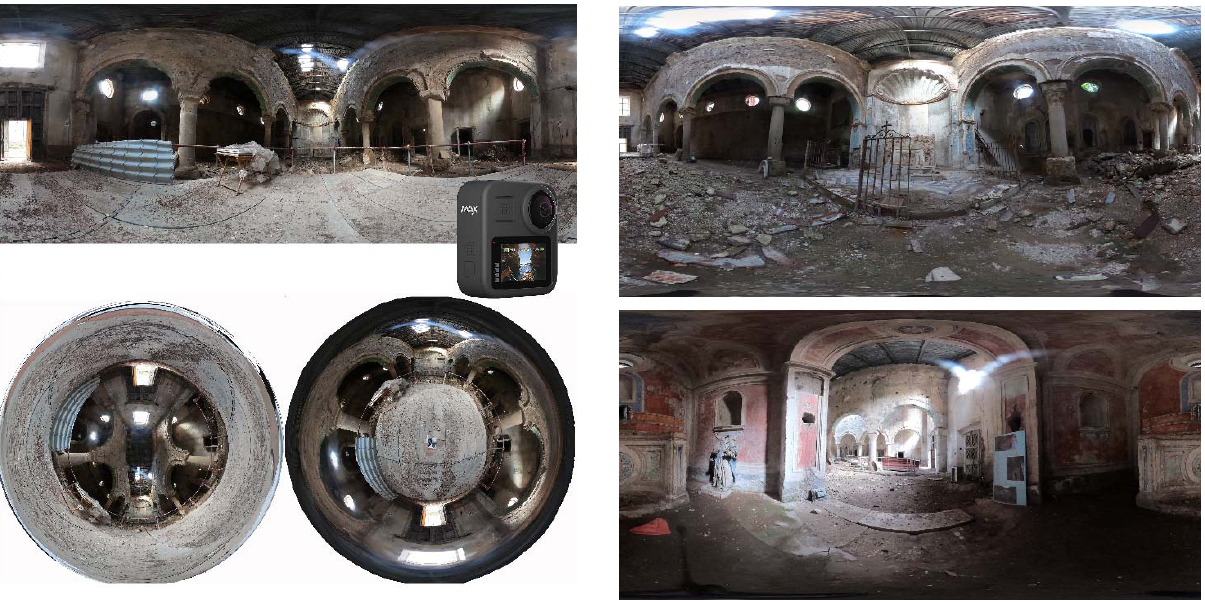
Figures 13-14. Spherical and tiny-planet photographic dataset